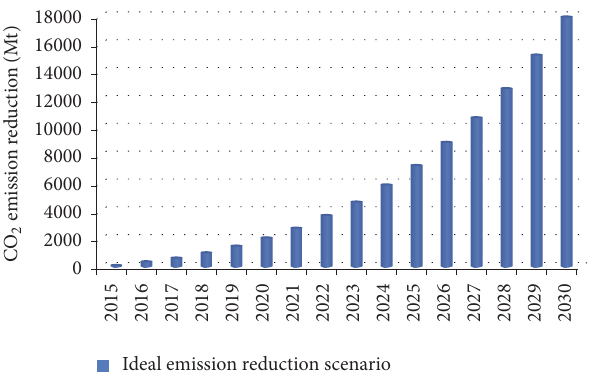
Figure 10: CO 2 emission reduction potential in China’s power